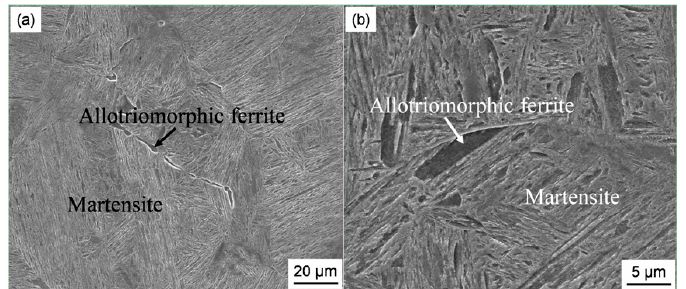
Figure 8. SEM micrographs of Alloy 1 that consists of martensite and a little allotriomorphic ferrite (Specimen was austenitized at 1000 °C for 30 min, then isothermally transformed at 700 °C for 5 h, before being quenched into the water at room temperature). ( a ) 1000 magnification times and, ( b ) 4000 magnification times.